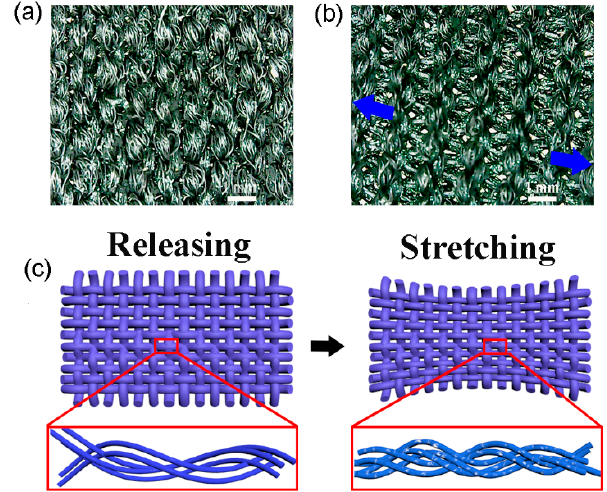
Figure 6. Microscopic images of a PPy-coated polyester / spandex textile at the releasing ( a ) and stretching ( b ) states. ( c ) schematic illustration of the structural change of the PPy-coated polyester / spandex textile under a stretching force. Arrows in ( b ) show the stretching direction.